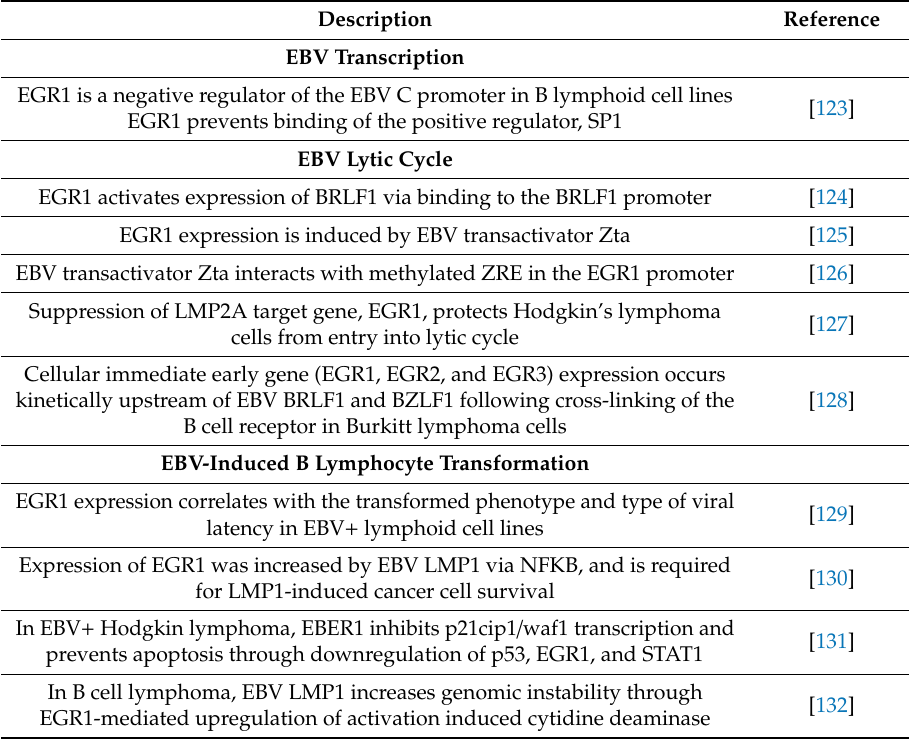
Table 3. Early growth response (EGR) genes in Epstein–Barr virus (EBV)